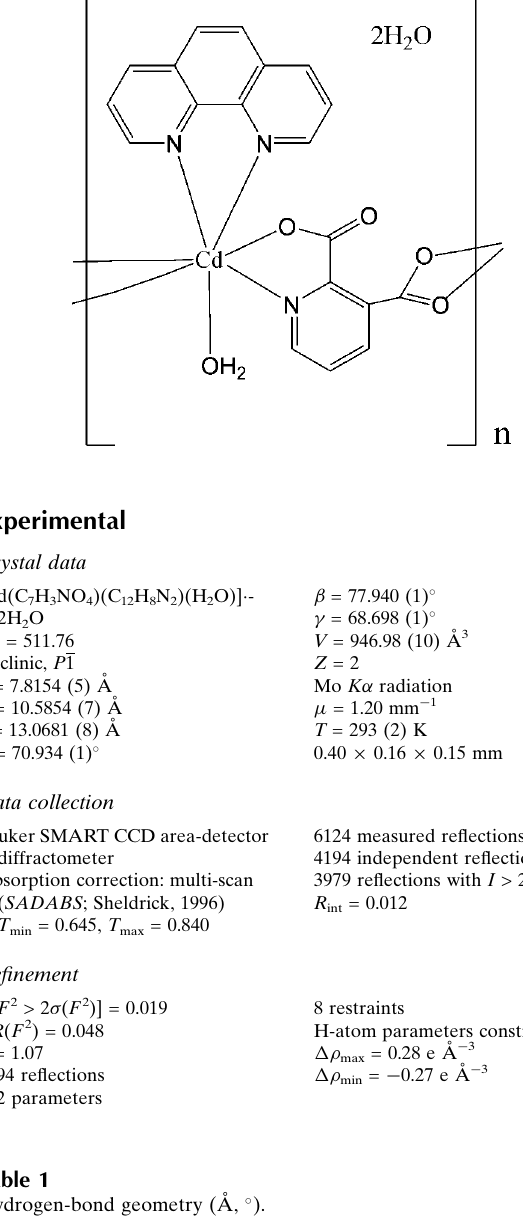
Hydrogen-bond geometry (A˚ , (cid:2) ). D —H (cid:1)(cid:1)(cid:1)